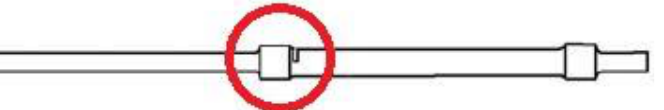
Figure 2. Location of the crack. Table 1. Defect level of the axle (crack depth).